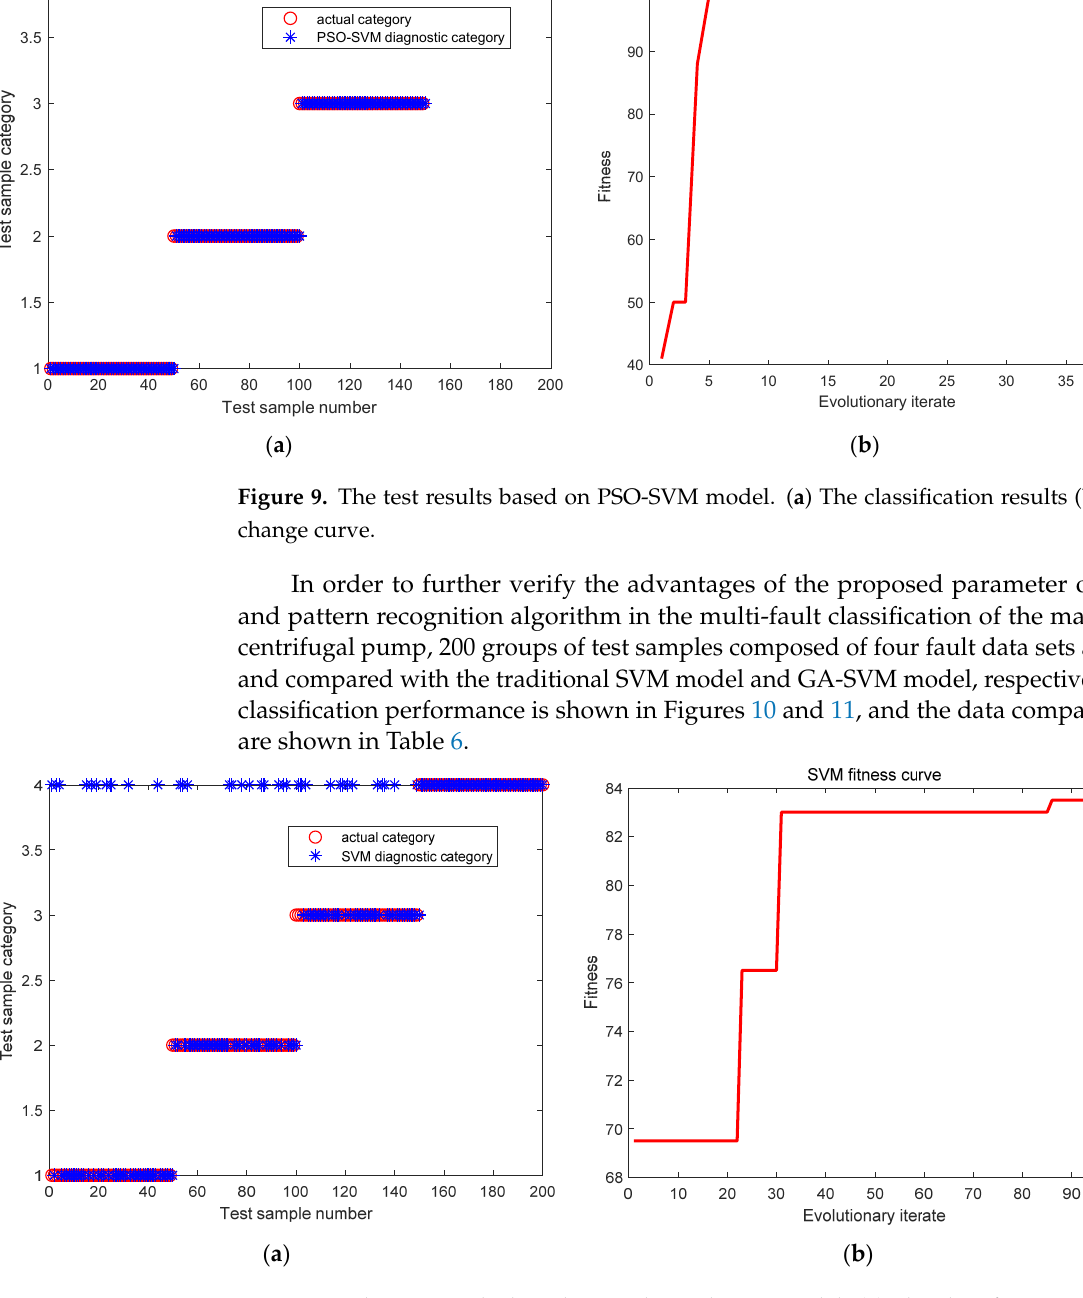
( b ) Figure 11. The test results based on GA-SVM model. ( a ) The classification results ( b ) The fitness change curve. It can be found from Table 6 that the classification accuracy of test samples based on the traditional SVM model is only 0.83, and that the accuracy of those based on the GA- SVM model is 0.96. The classification accuracy of 200 groups of test samples based on the PSO-SVM recognition model is 1, the fitness is 98.8%, and the convergence speed is the fastest. The classification performance of the PSO-SVM model on test samples is signifi- cantly better than that of traditional SVM and GA-SVM models. The F-1 score based on the PSO-SVM model reached 1, which is higher than the both of the other models. The superiority of the proposed PSO-SVM algorithm in multi-fault classification of vertical centrifugal pumps is comprehensively verified. 0